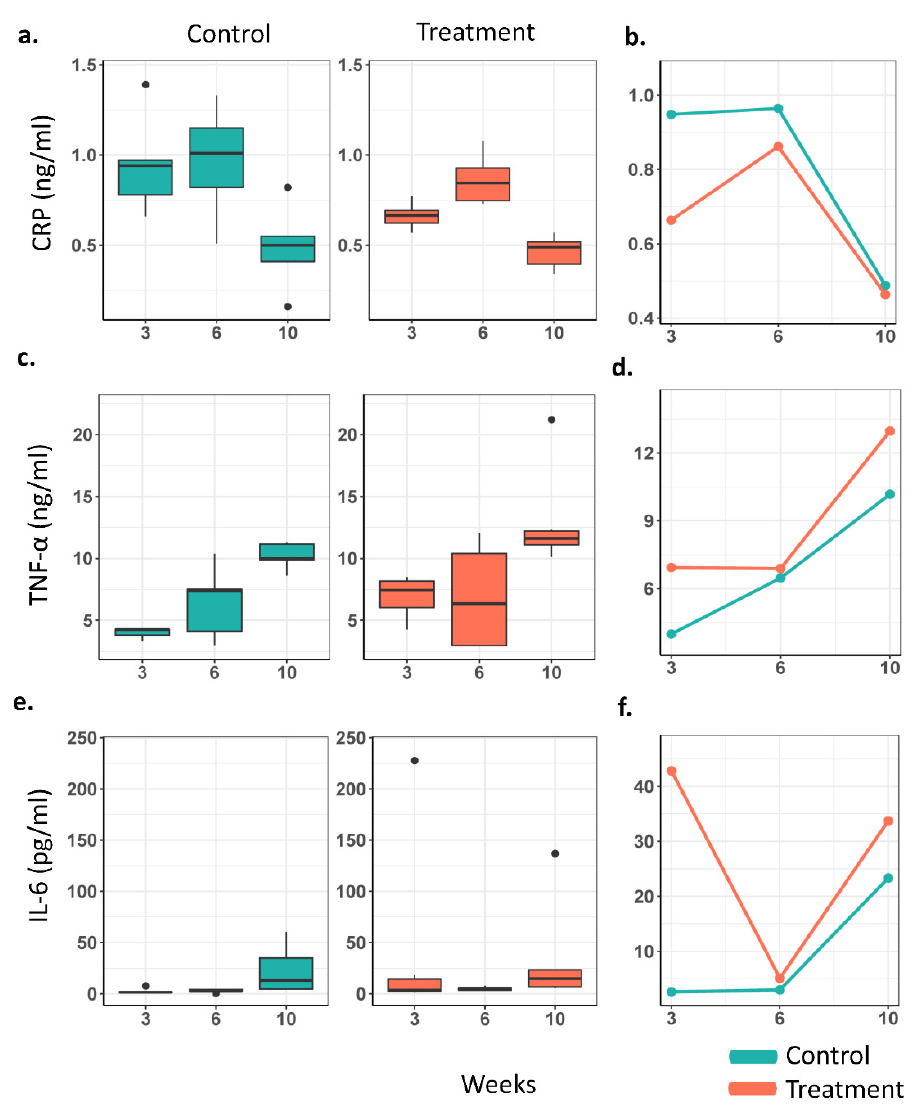
Figure 7. Proinflammatory serum level distribution and mean values over time in the GI microbiota dysbiosis (treatment) ( n = 6) and control ( n = 5) groups at 3, 6, and 10 weeks. ( a , b ) C ‐ reactive protein, ( c , d ) tumor necrosis factor ‐ alpha, ( e , f ) interleukin ‐ 6.